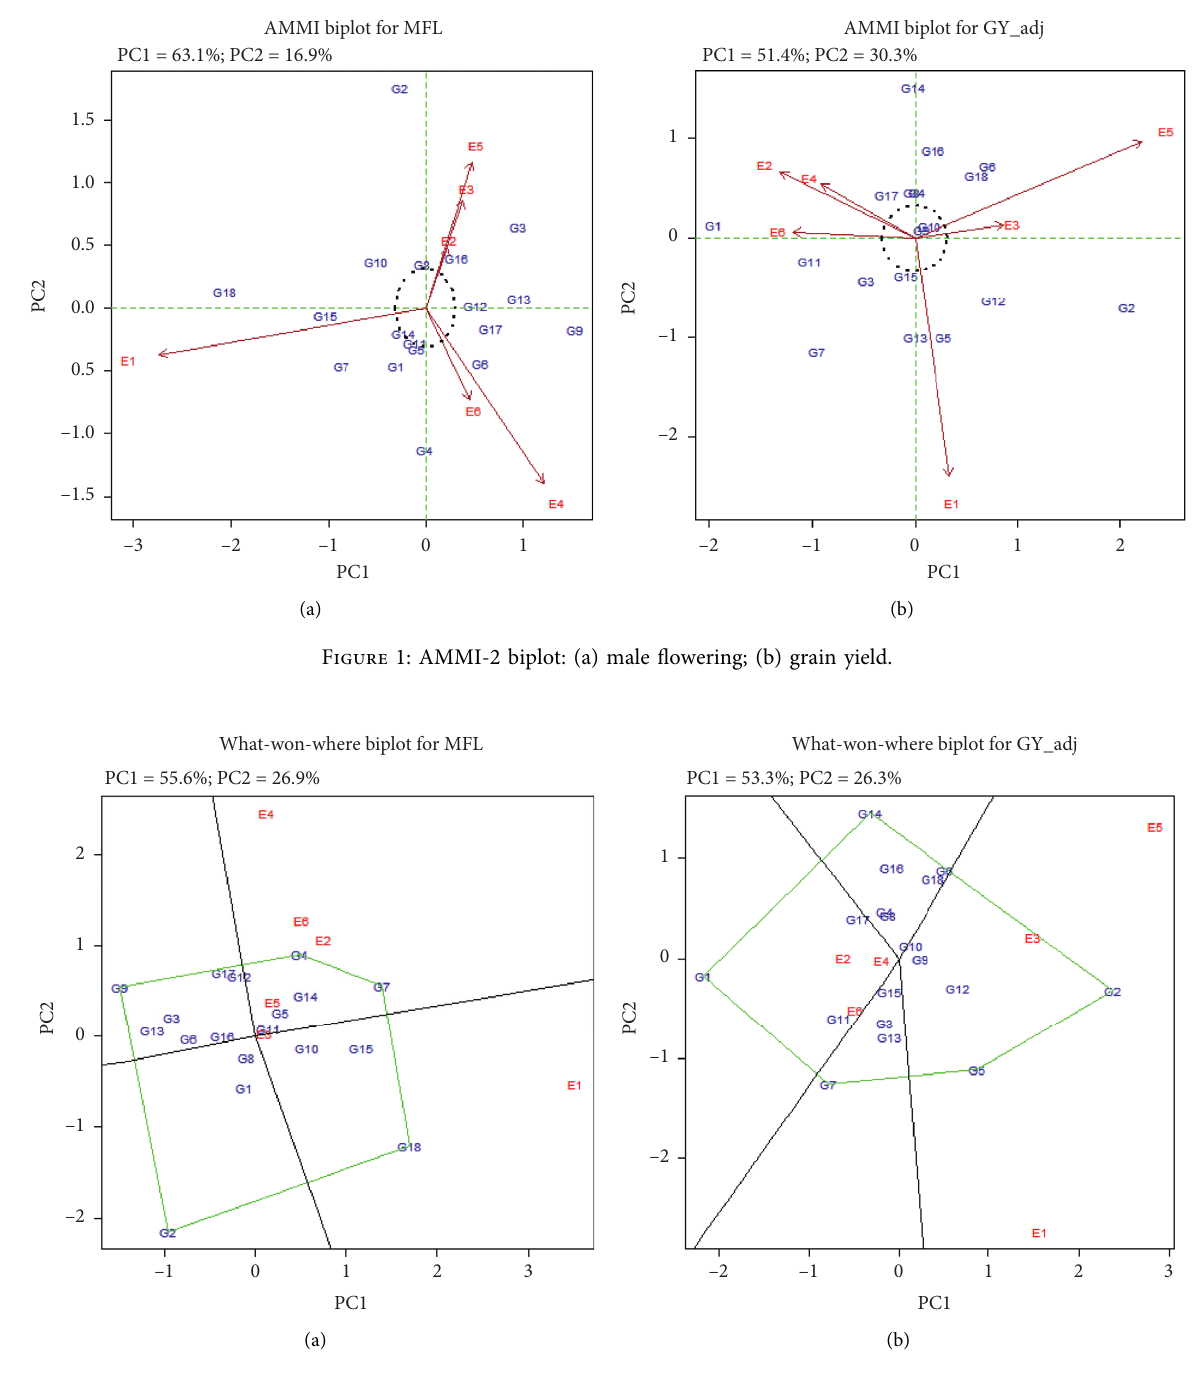
Figure 2: GGE biplot: (a) male flowering; (b) grain yield.